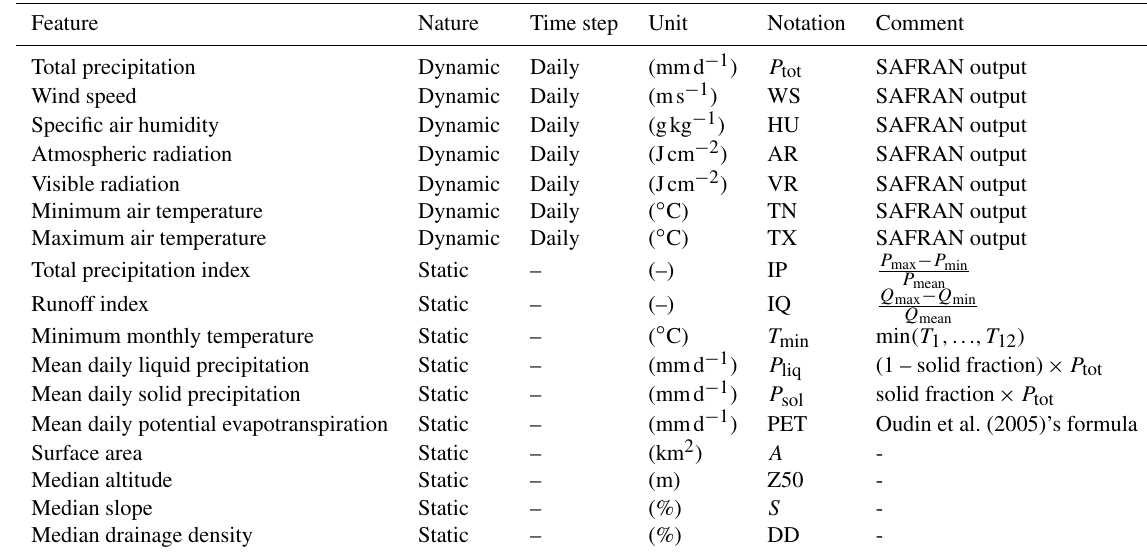
Table 3. List of the dynamic and static features used in different LSTM models in the paper. Feature Nature Time step Unit Notation Comment Total precipitation Dynamic Daily Wind speed Dynamic Daily WS Specific air humidity Dynamic